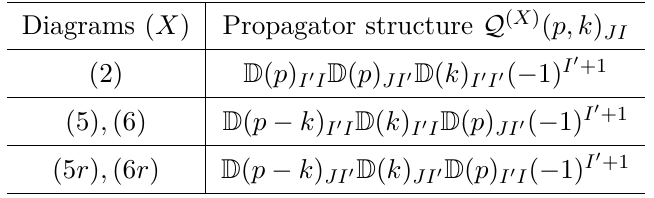
Figure 5. List of all diagrams contributing to the electric field correlator (3.5), with free indices ( I, i, a ) and ( J, j, d ) for the corresponding electric field insertions. The long dashed lines represent the Wilson lines while the short dashed lines label the ghost field. Solid lines indicate the fermion field. The two grey blobs are the electric fields.